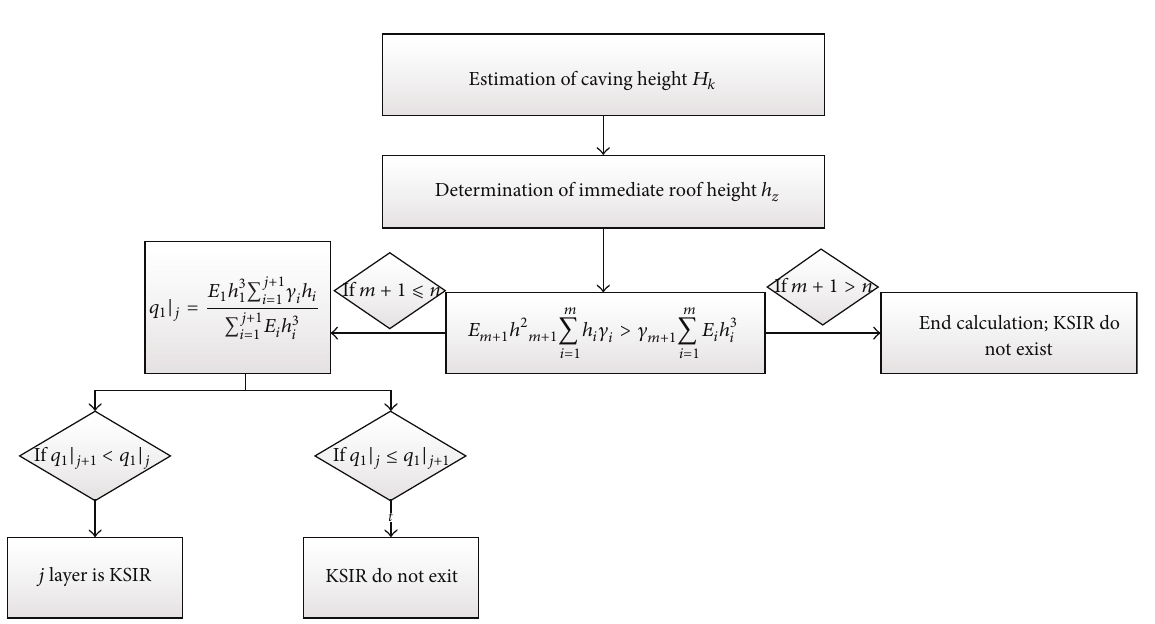
Figure 2: Derivation procedure of